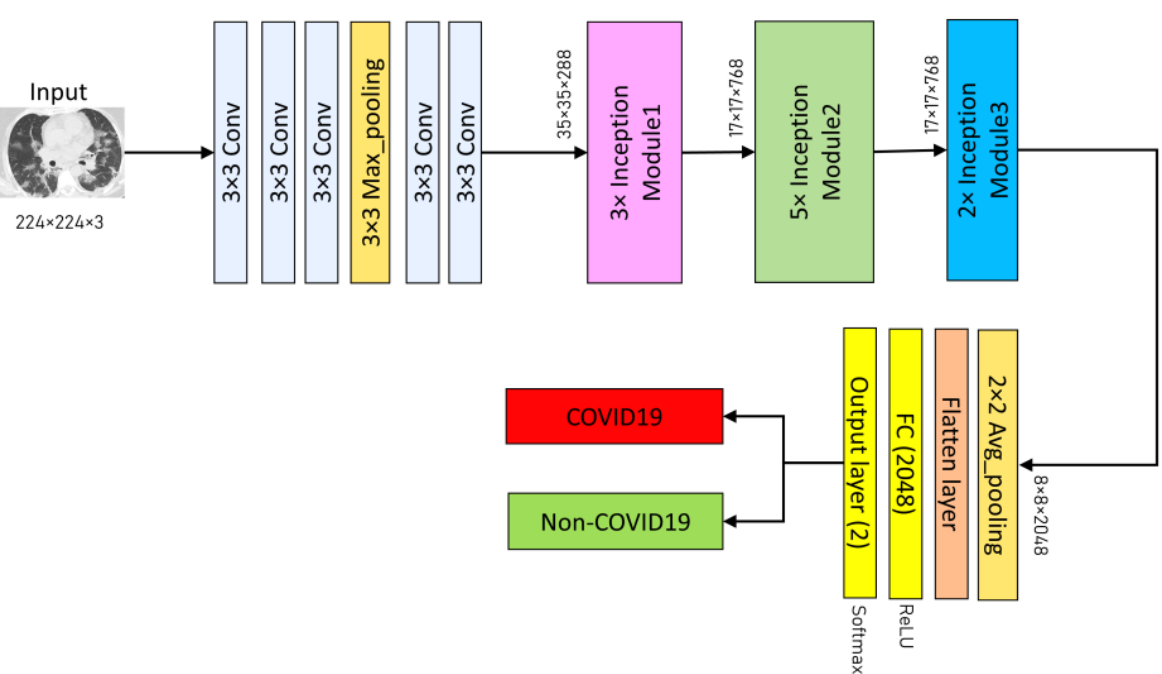
Figure 3. Architecture of the proposed InceptionV3 model.